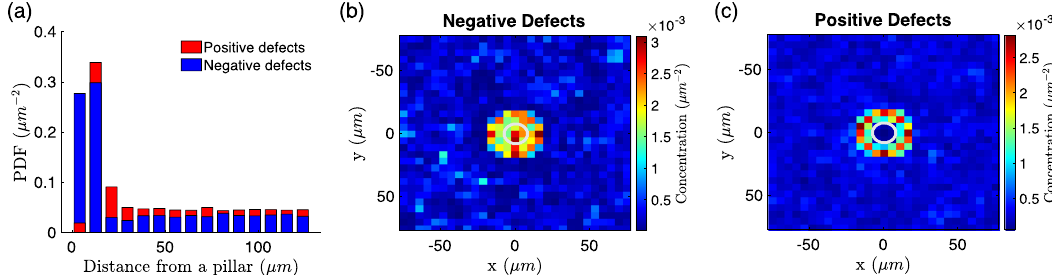
Fig. 5 Simulations for pillars of circular cross-section. a The probability density function of positive and negative defects vs the distance from the pillar center. The concentration of negative ( b ) and positive ( c ) defects, the pillars' contours are depicted by the white lines. The color bars represent the defect concentrations. The graininess of ( b ), ( c ) is due to the coarse binning of the defect probability